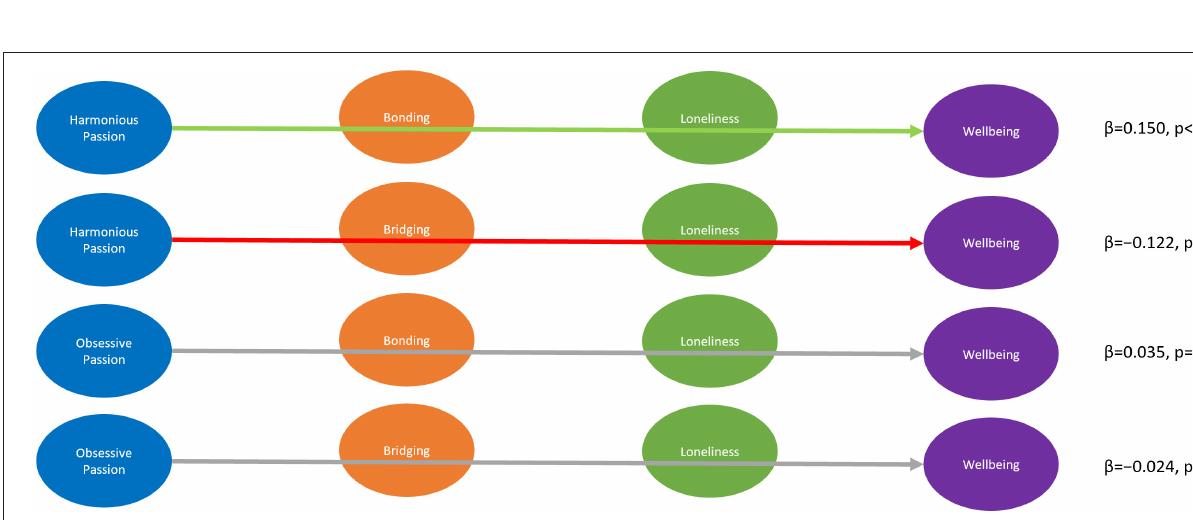
FIGURE 5 | Indirect Effects from Passion on Wellbeing mediated by Social Capital and Loneliness. β denotes unstandardized coefficients.